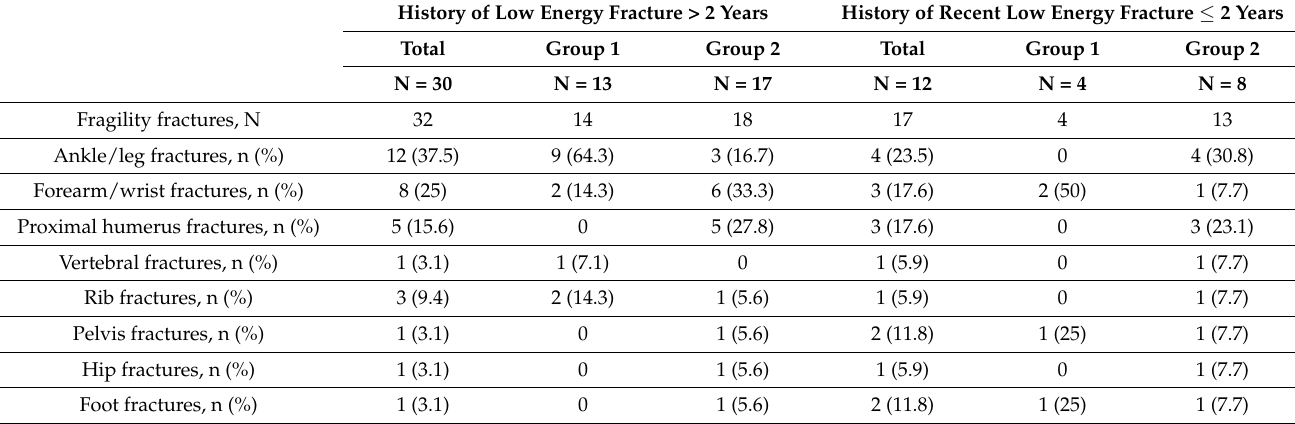
Table 2. Patients’ fragility fracture characteristics at